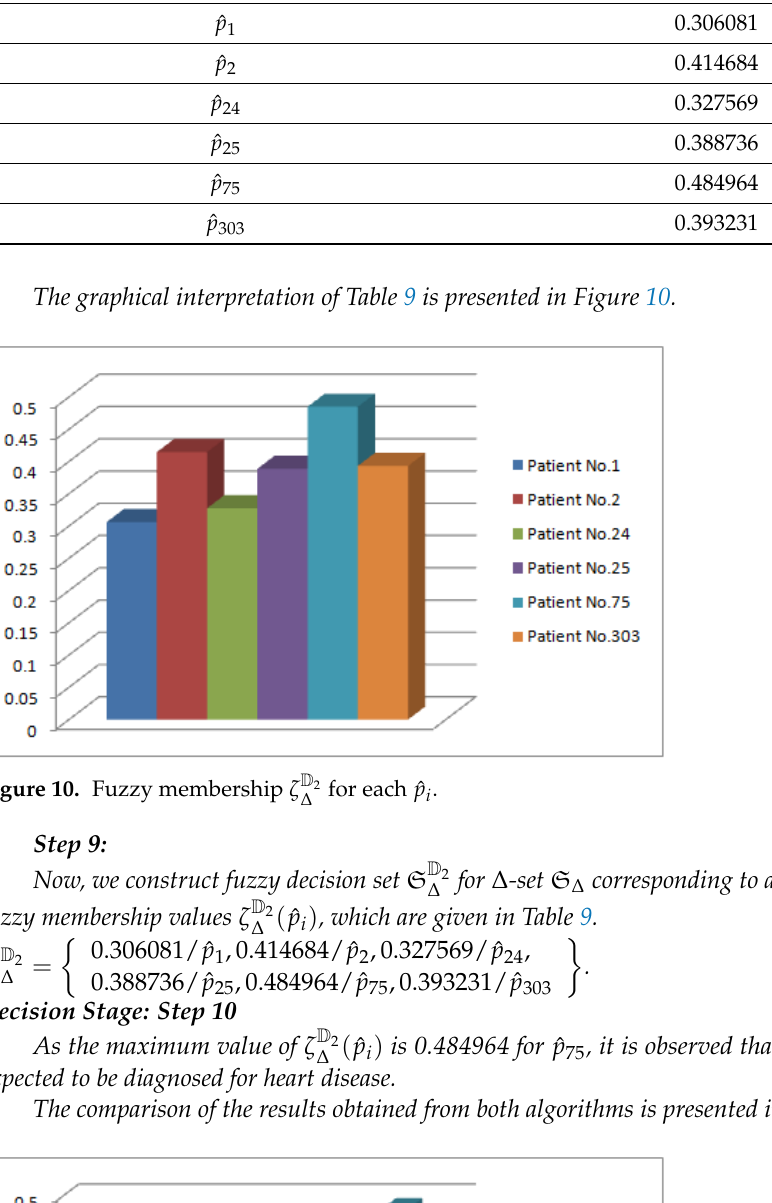
Table 9. Fuzzy membership ζ